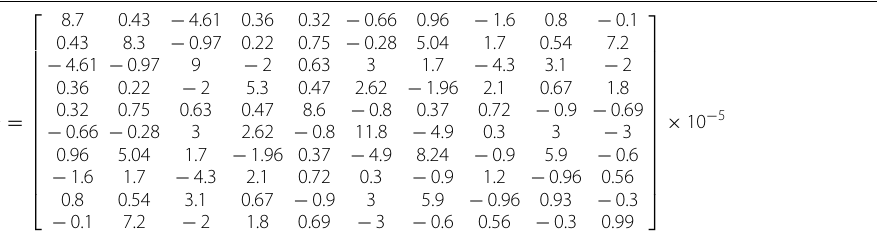
Table 8 B -matrix coefficients (per